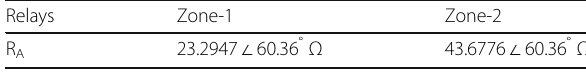
Table 3 Zone Settings of the distance relay R